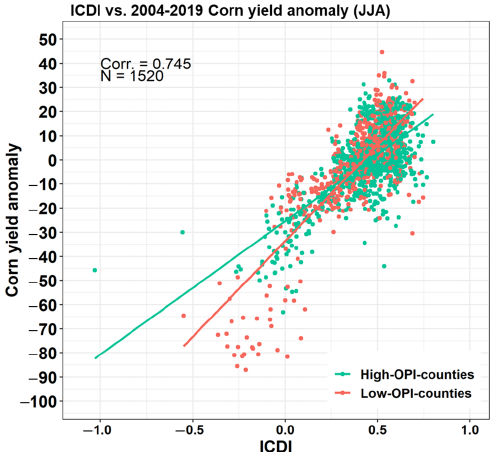
Figure 12. Relationship between the average ICDI in summer (JJA) and the corn yield anomaly, 2004–2019.